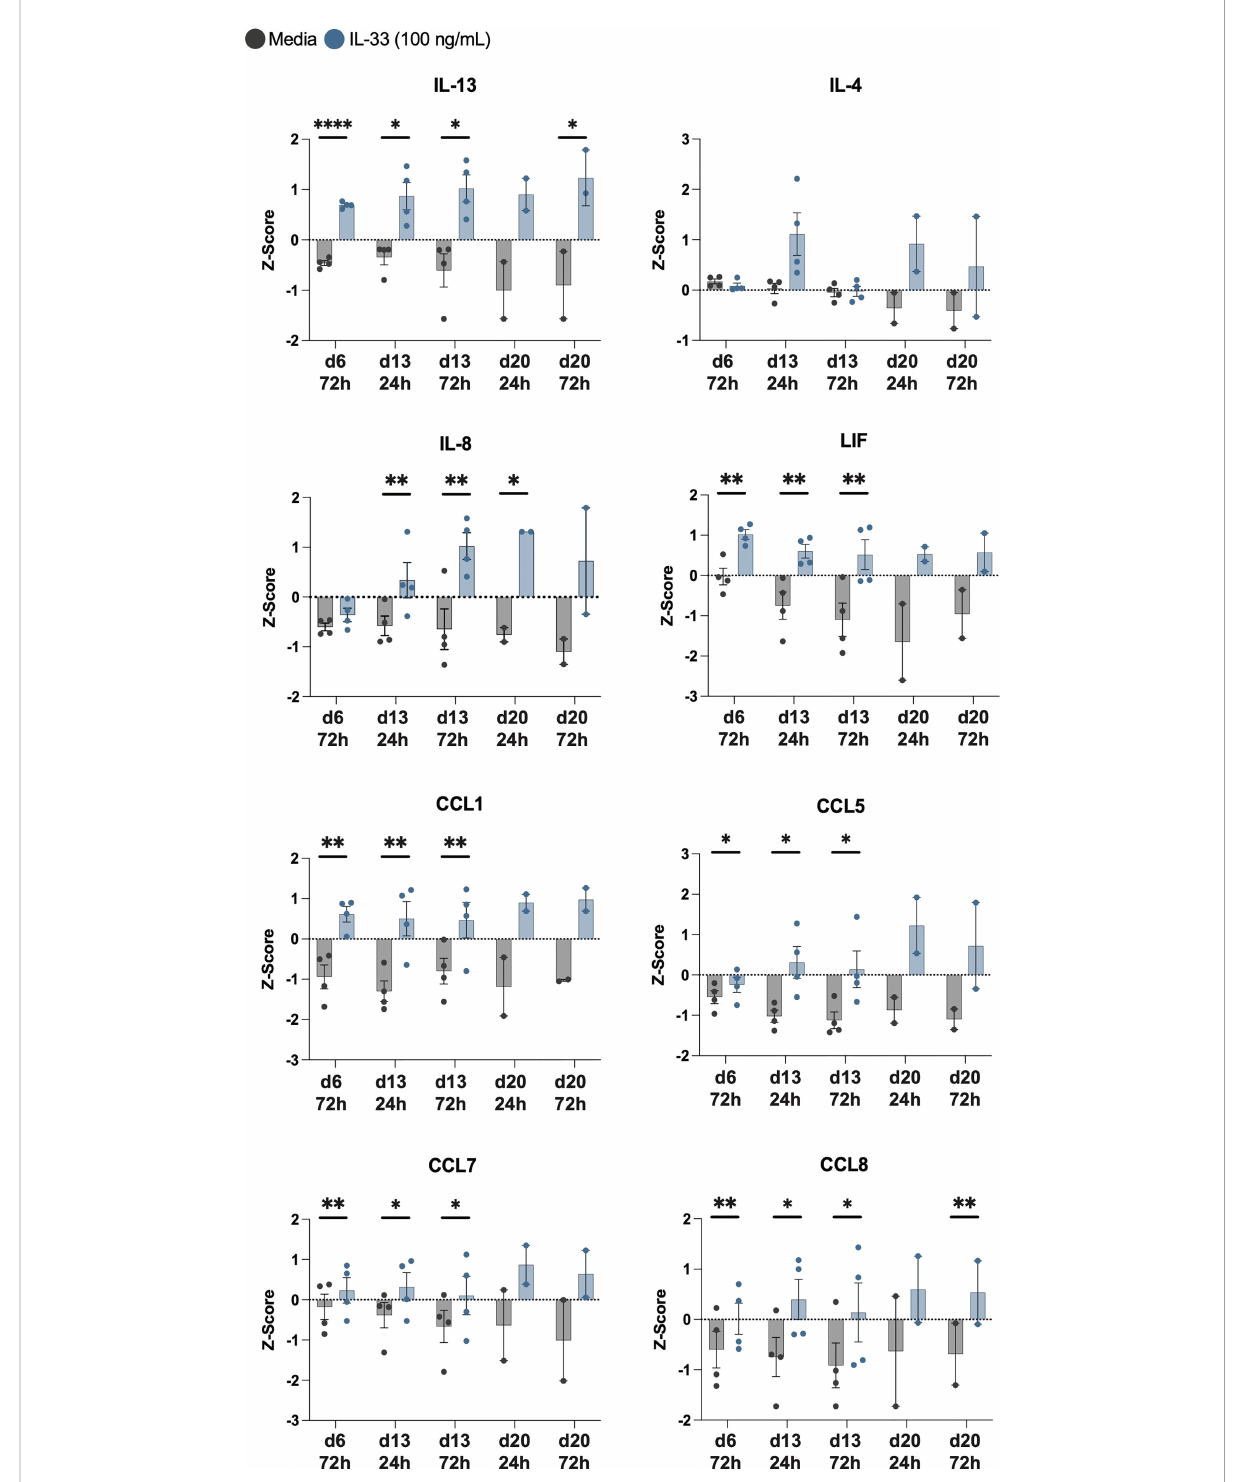
FIGURE 5 IL-33 signi fi cantly increases release of IL-13 among other cytokines from differentiated eosinophils. Z-scores of cytokines consistently upregulated by IL-33 treatment compared to media controls are displayed in addition to IL-4. P<0.05 (*), <0.0021 (**), <0.0001